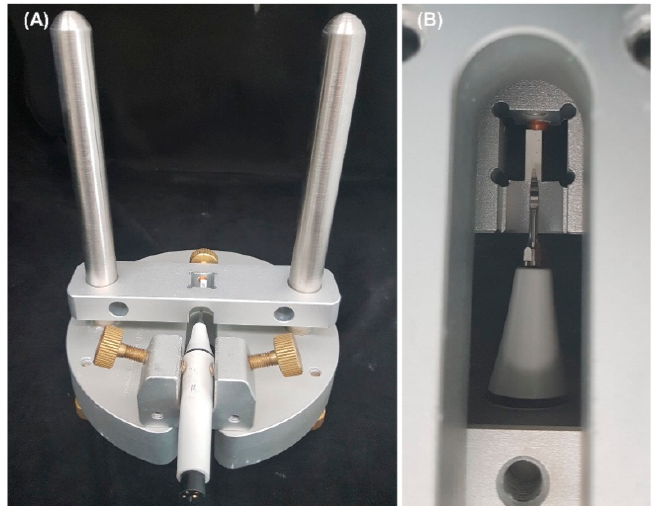
Figure 3. ( A ) Custom jig used to test the wear of a stainless-steel ultrasonic scaler tip. ( B ) Shape of a stainless-steel ultrasonic scaler tip during the wear test, as seen from the